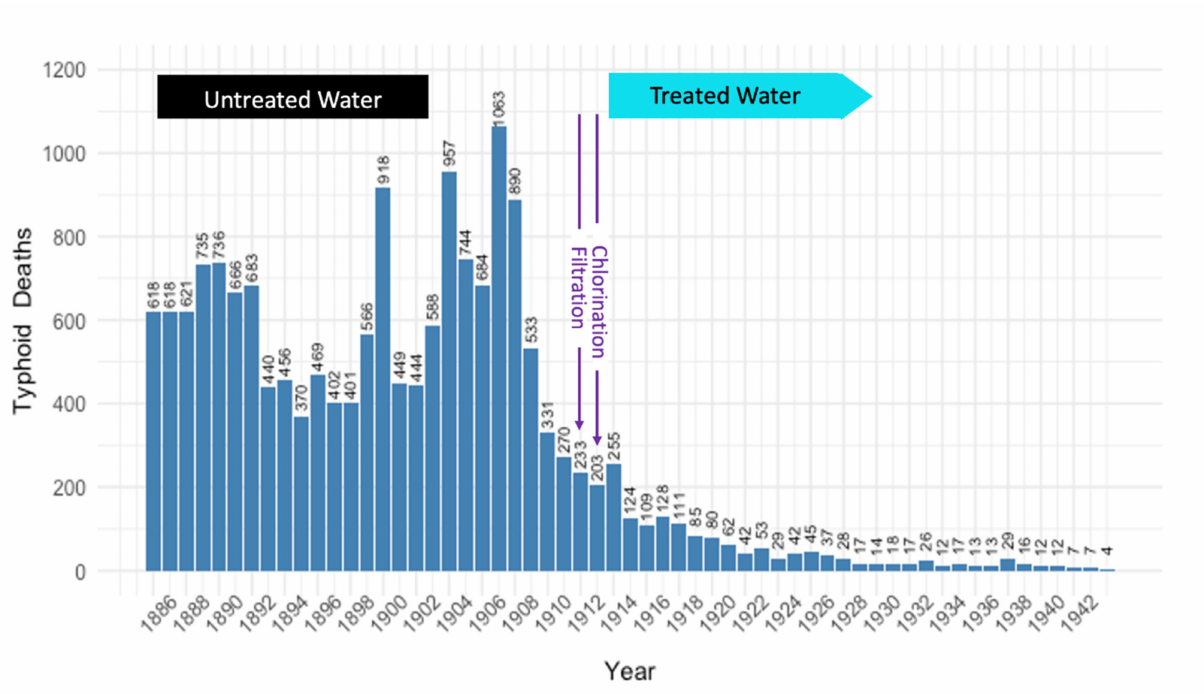
Figure 2. Typhoid deaths in Philadelphia drastically dropped after city-wide water filtration (1912) and chlorination (1913) [Adapted from [53]. Data from the Philadelphia Water Department